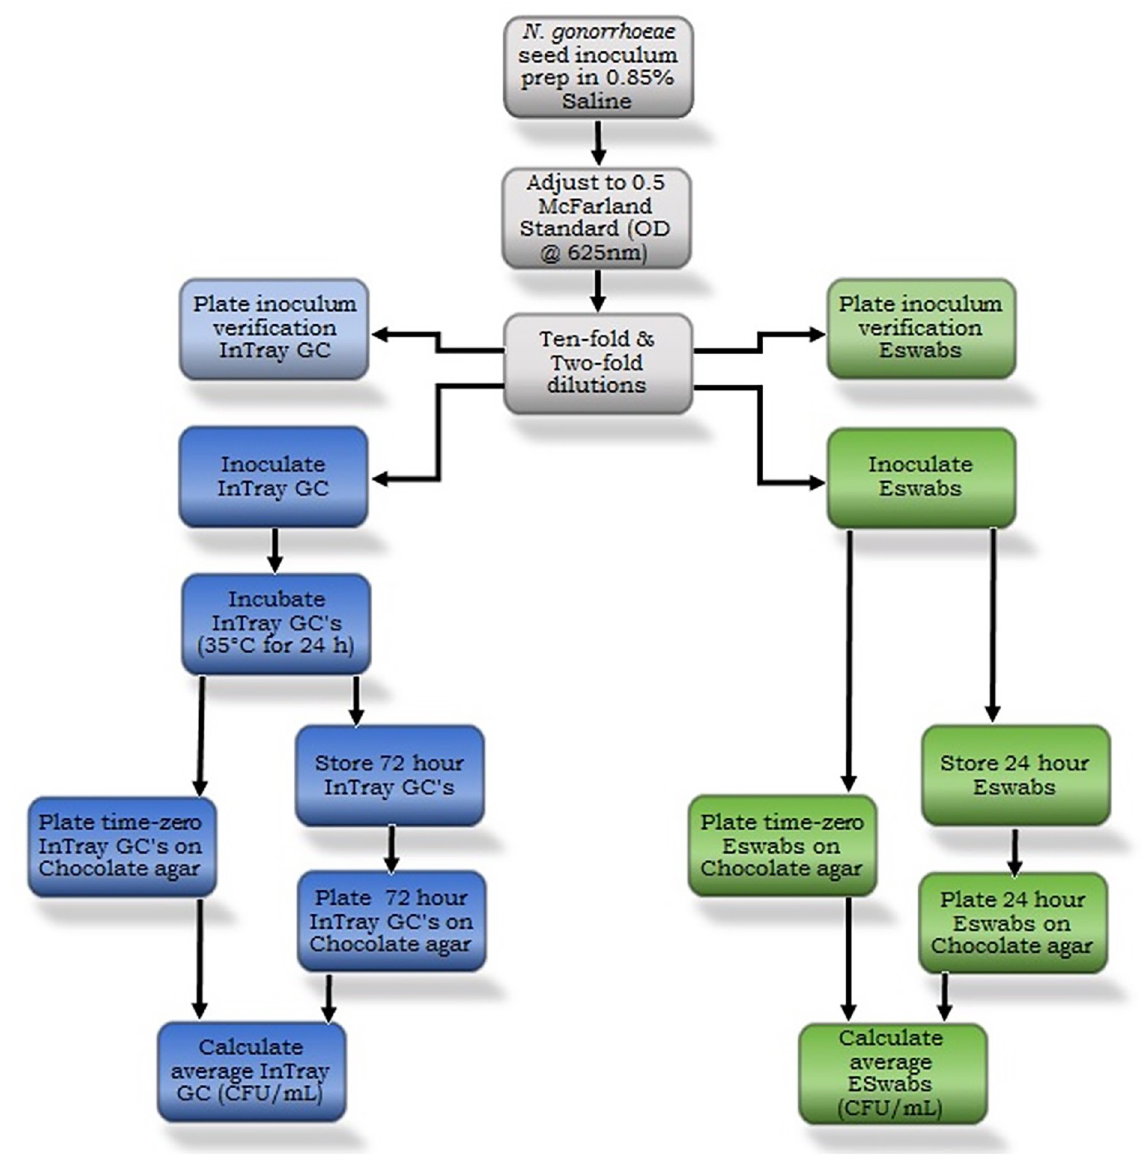
Fig 1. Methods flowchart for the InTray GC and ESwab transport recovery of Neisseria gonorrhoeae isolates.